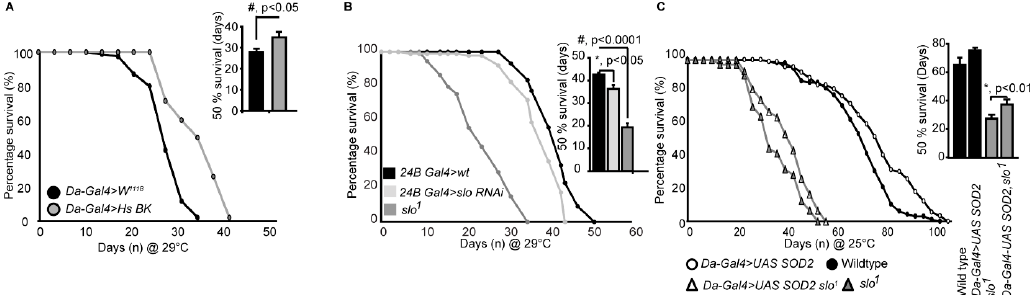
Figure 6. slo 1 expression modulates survival. ( A ) Males overexpressing human (Hs) BK Ca increase life span. Inset shows quantification of 50% survival of control and Hs BK Ca overexpressing flies. ( B ) Lifespan of control, slo RNAi under 24B Gal4 and slo 1 mutants at 29 °C. ( C ) slo 1 mutants are partially rescued by the overexpression of Daughterless Gal4 ‐ UAS; Sod2. Inset histograms represent the 50% survivability of the mutants. Histograms represent the 50% survivability of the mutants in both ( B ) and ( C ).